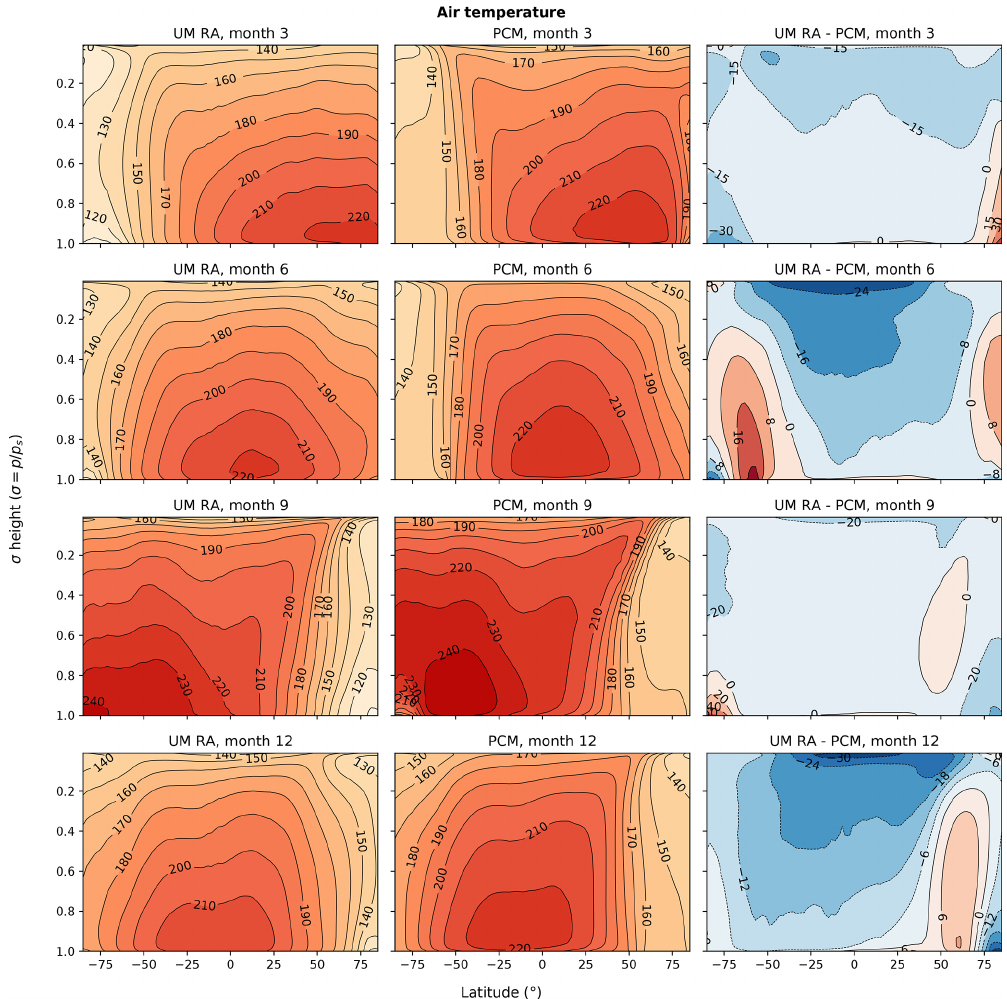
Figure A8. Zonal mean air temperature (K) across four seasons within the Martian year. For each month, the time average is taken of all sols within that month. The RA dust scenario is shown on the left, the PCM output in the centre and the differences between models on the right. Colour scales in the left-hand and right-hand plots are matched across all months and between models, with contour intervals of 10K. The contours in the difference plots are not matched due to the varying intensity of the difference between